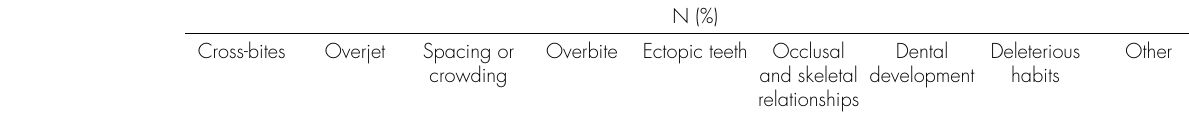
Table IV. Clinical conditions assessed during orthodontic screening by demographic